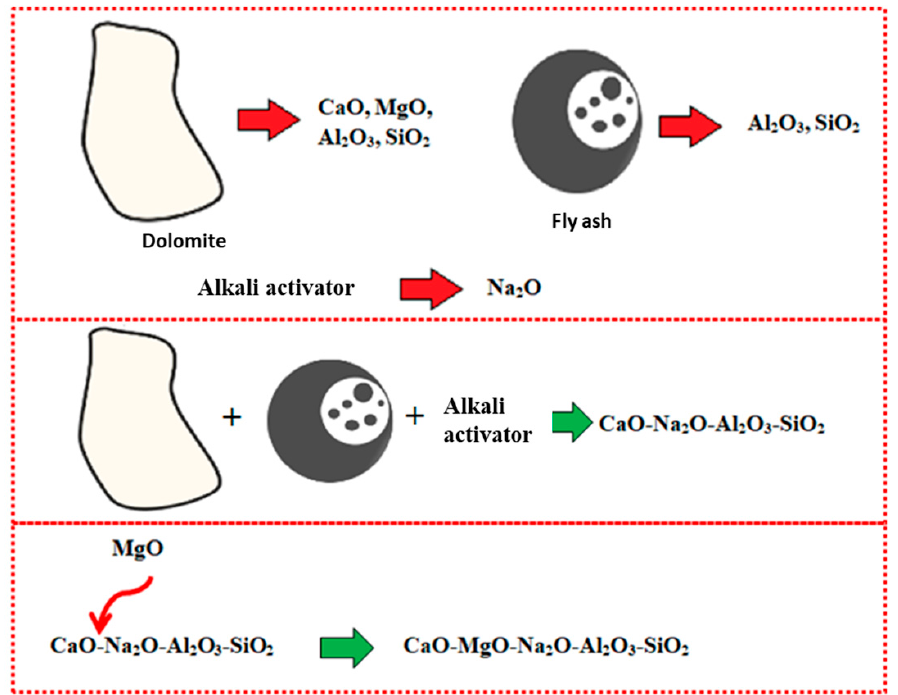
Figure 5. Schematic of Magnesium Oxide (MgO) interference in geopolymer system.